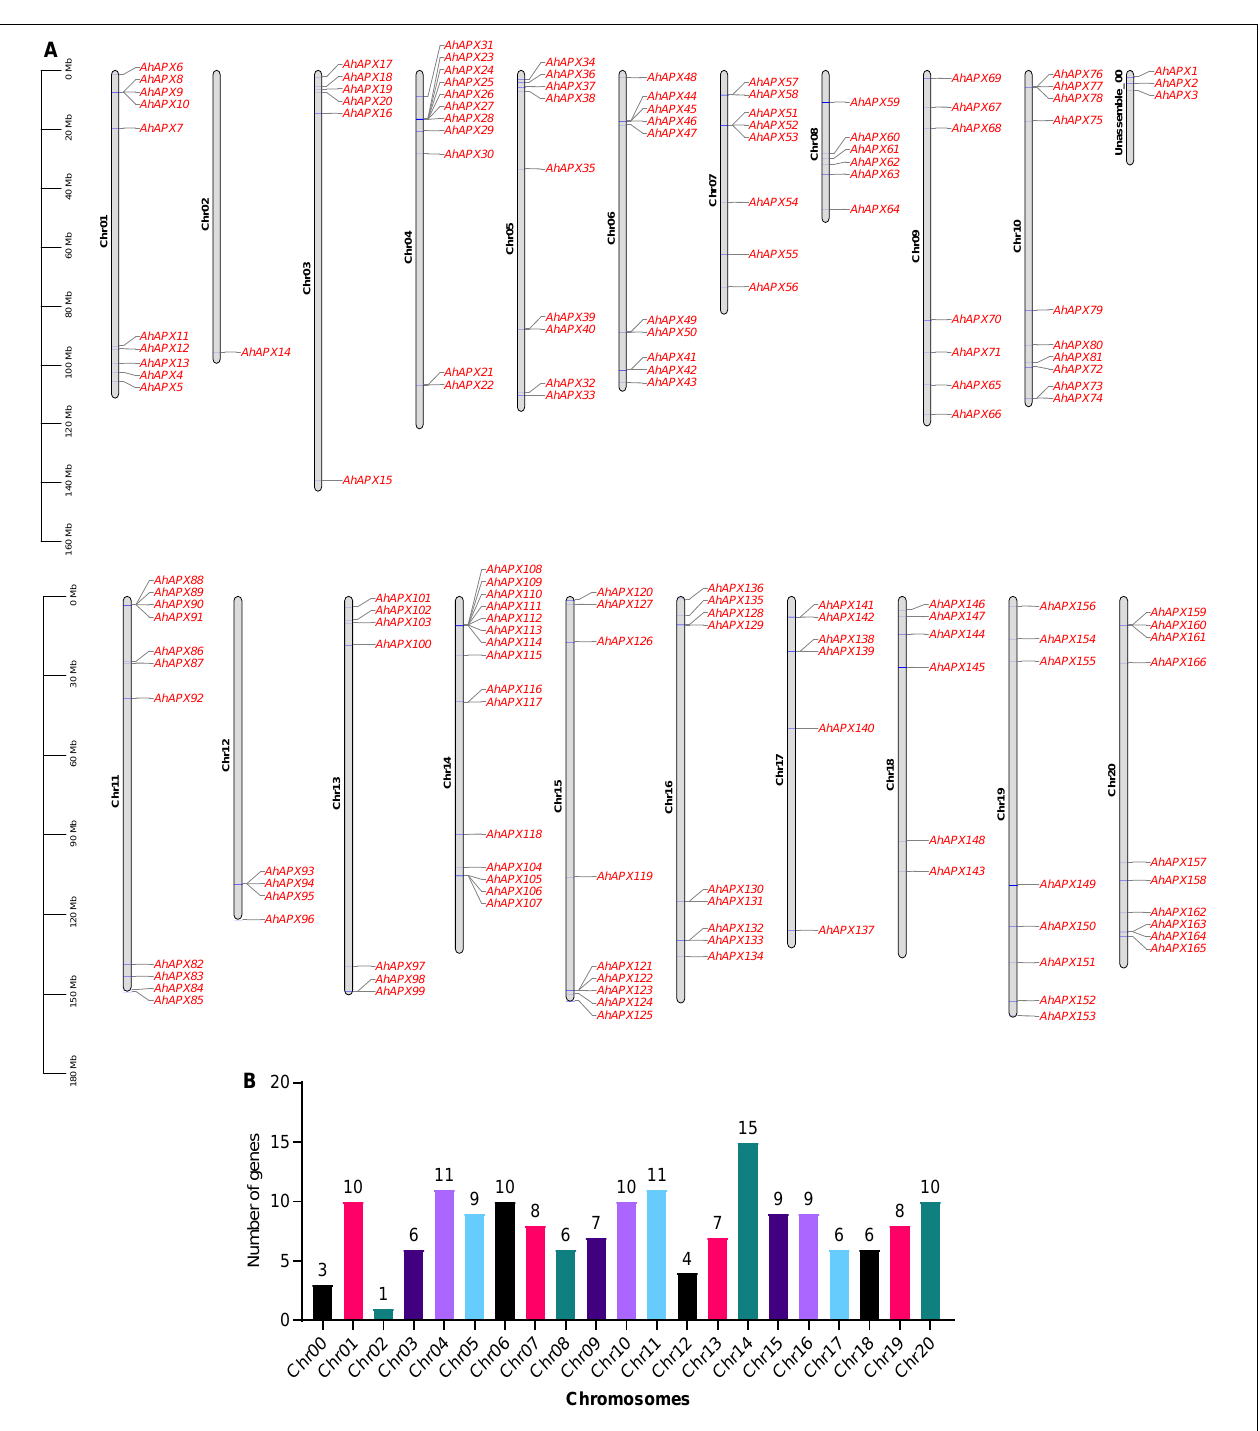
FIGURE 1 | Chromosomal mapping of AhAPX genes on A. hypogea genome. (A) Distribution map of AhAPX genes on 20 chromosomes, including one unassembled region. Representative chromosome numbers are shown on the left side of each bar. The scale on the left side represents the chromosomal distance and is in megabases (Mb). (B) Graph indicates the number of AhAPX genes mapped on each